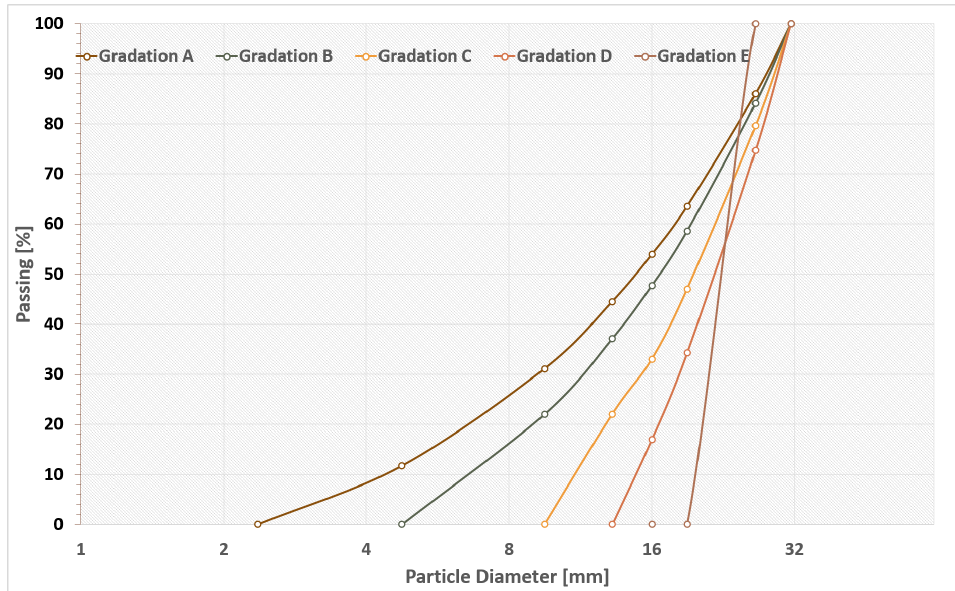
Figure 7. Five different gradation curves for triaxial testing of permeable subbase materials in China [52].